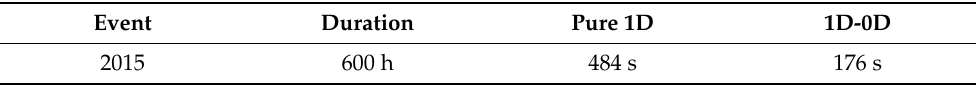
Table 3. Computational times for 2015 flood event simulated in the Ebro River with the 1D-0D model and the pure 1D model, both with the dam regulated with a PID